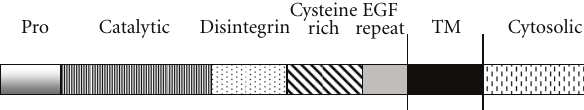
Figure 3: The domain structure of a disintegrin and metallopro- teinases (ADAMs).